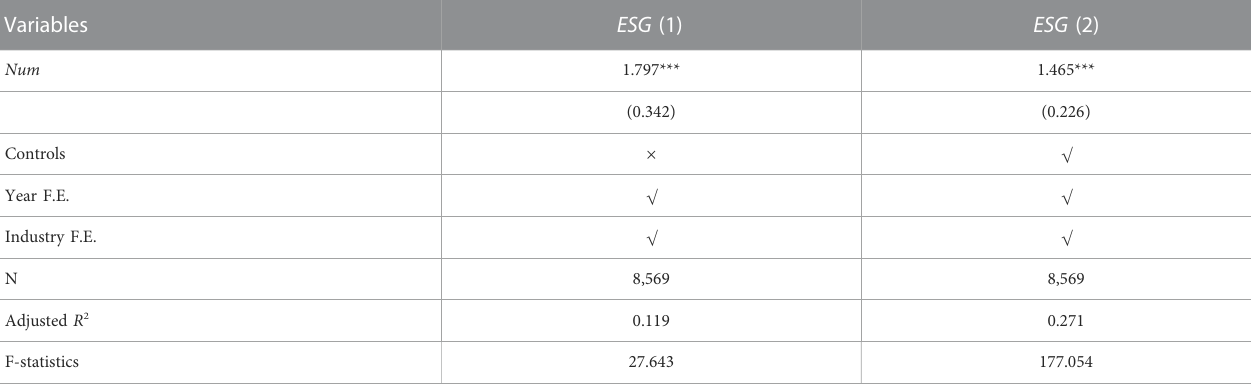
TABLE 6 The role of other large shareholders.